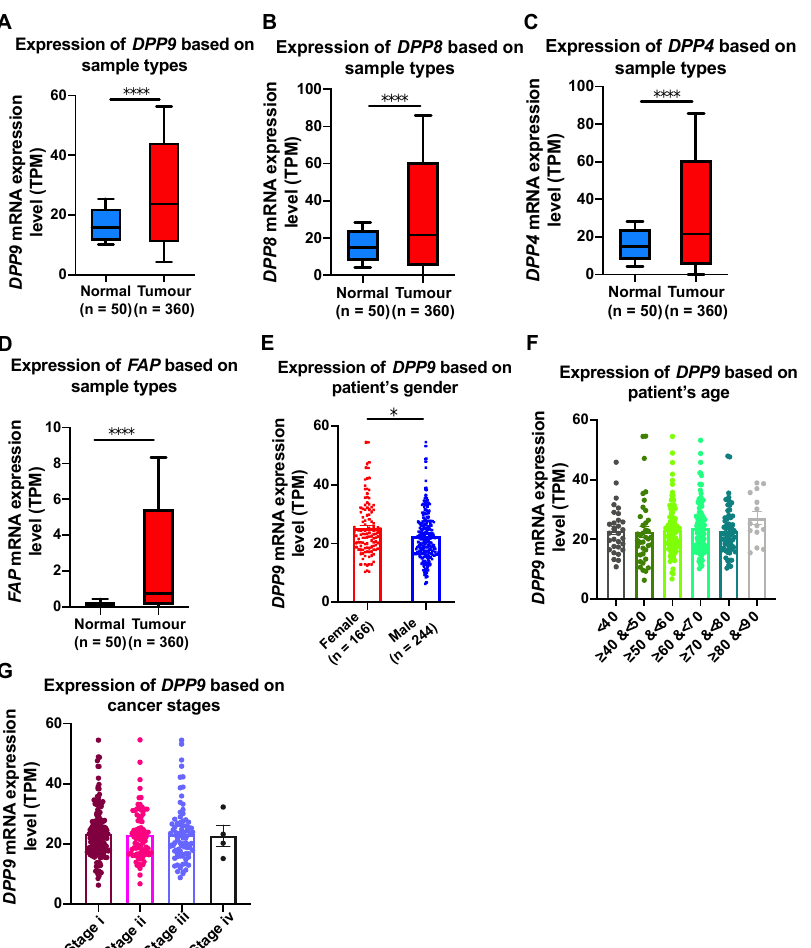
Figure 2. The relative mRNA expression level of DPP9, DPP8, DPP4 and FAP in liver tumors ( A – D ) and association of DPP9 expression with gender ( E ), age ( F ) and cancer stages ( G ) in HCC patients. p values were calculated by Mann-Whitney U test ( A – E ) and Kruskal-Wallis one-way analysis of variance with Tukey’s post-hoc test ( F , G ). * p < 0.05, **** p < 0.0001.